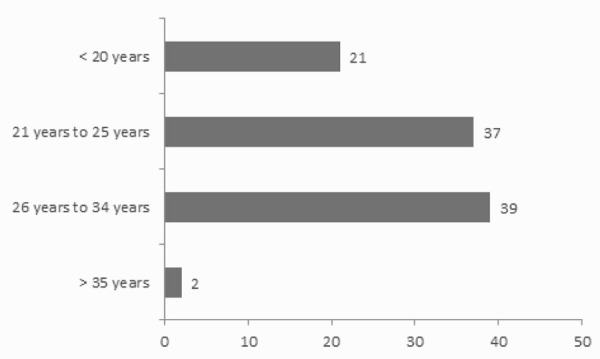
Age Distribution.